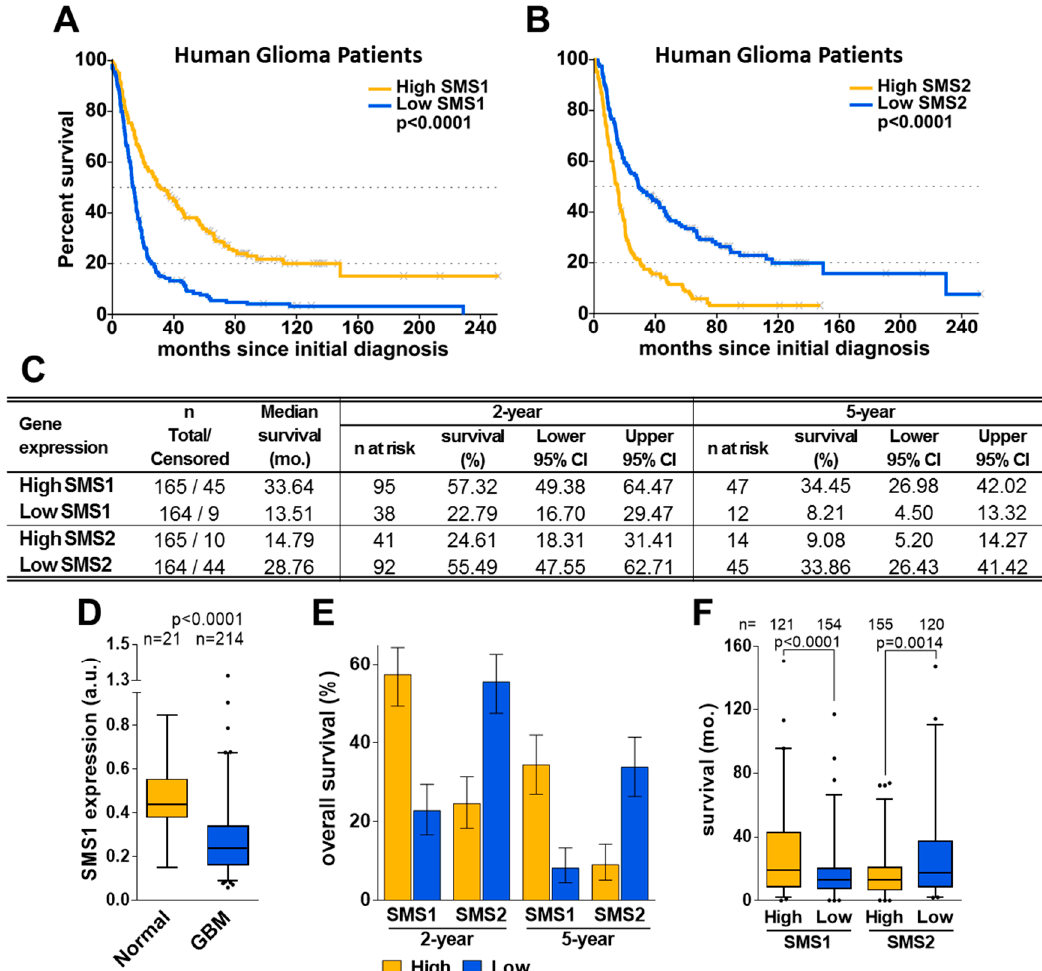
Figure 1. SMS1 and SMS2 expression and glioma patient survival. Kaplan-Meier plots showing the overall survival of glioma patients (from the REMBRANDT database) as a function of SMS1 ( A ) or SMS2 ( B ) expression. ( C ) Survival parameters (mo.: months; n: number of patients; CI: confidence interval). ( D ) SMS1 expression comparison in brain tissue from healthy subjects (Normal) and GBM patients. ( E ) Two- and five-year survival of glioma patients with high (orange) or low (blue) SMS1 and SMS2 expression. ( F ) Patient’s survival (months) depending on Low/High SMS1 (left) or SMS2 (right) expression (censored events, corresponding to alive patients, were excluded). The differences between groups were analyzed using a non-parametric Mann-Whitney test.